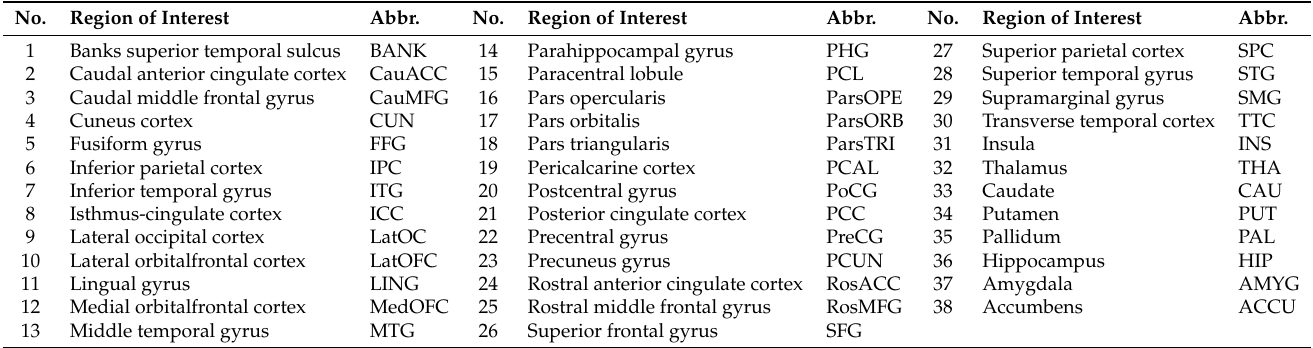
Table 2. List of regions-of-interest (ROIs) from Desikan